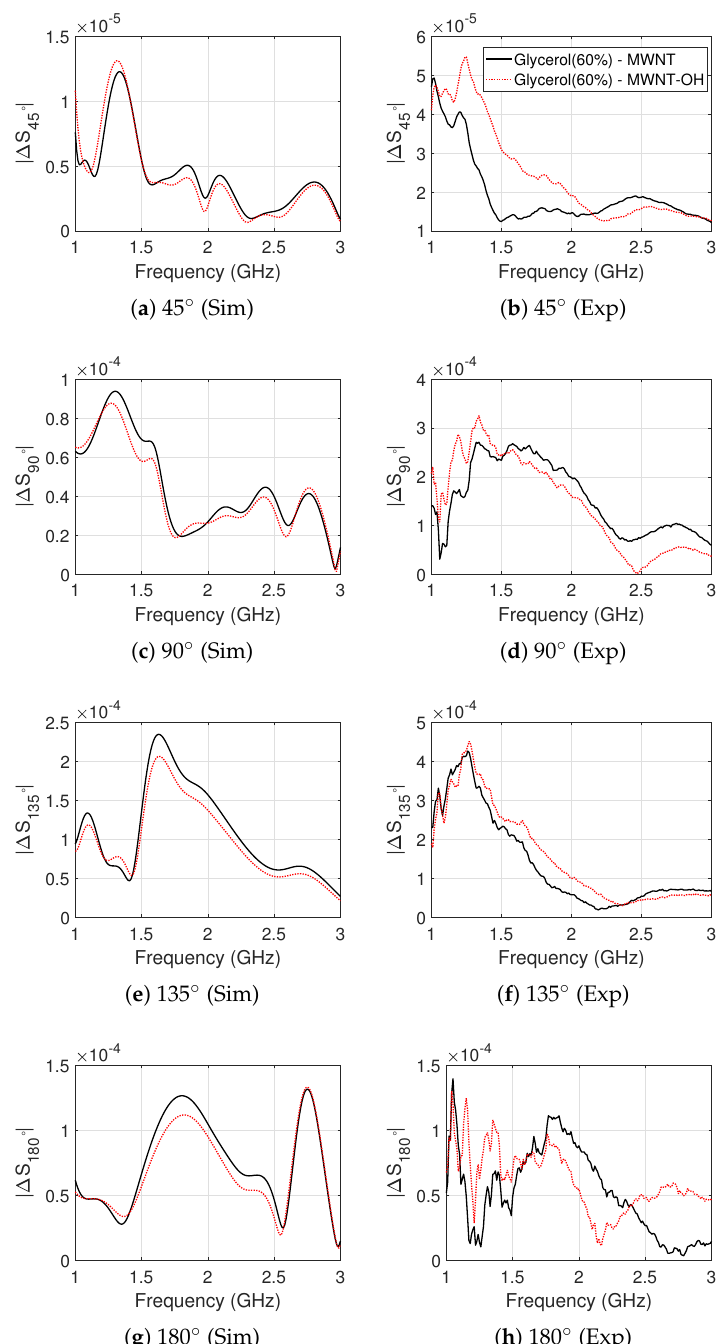
Figure 7. Difference in received signal strength between “no-target” and “target T2” cases, plotted for each receiver position against frequency. T2 is filled with MWNT and MWNT-OH colloidal suspensions with a concentration of 2 mg/mL dispersed in 60% glycerol. The simulated ( left ) and experimental ( right ) signal differences are plotted between 1.0 and 3.0 GHz, which is the operational frequency range for the employed